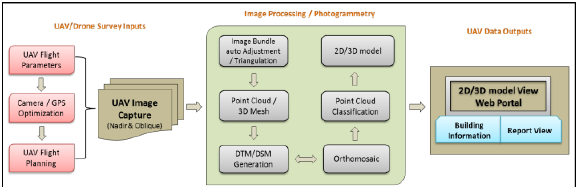
Figure 4: Flowchart representing automatic building information generation using UAVs/Drone